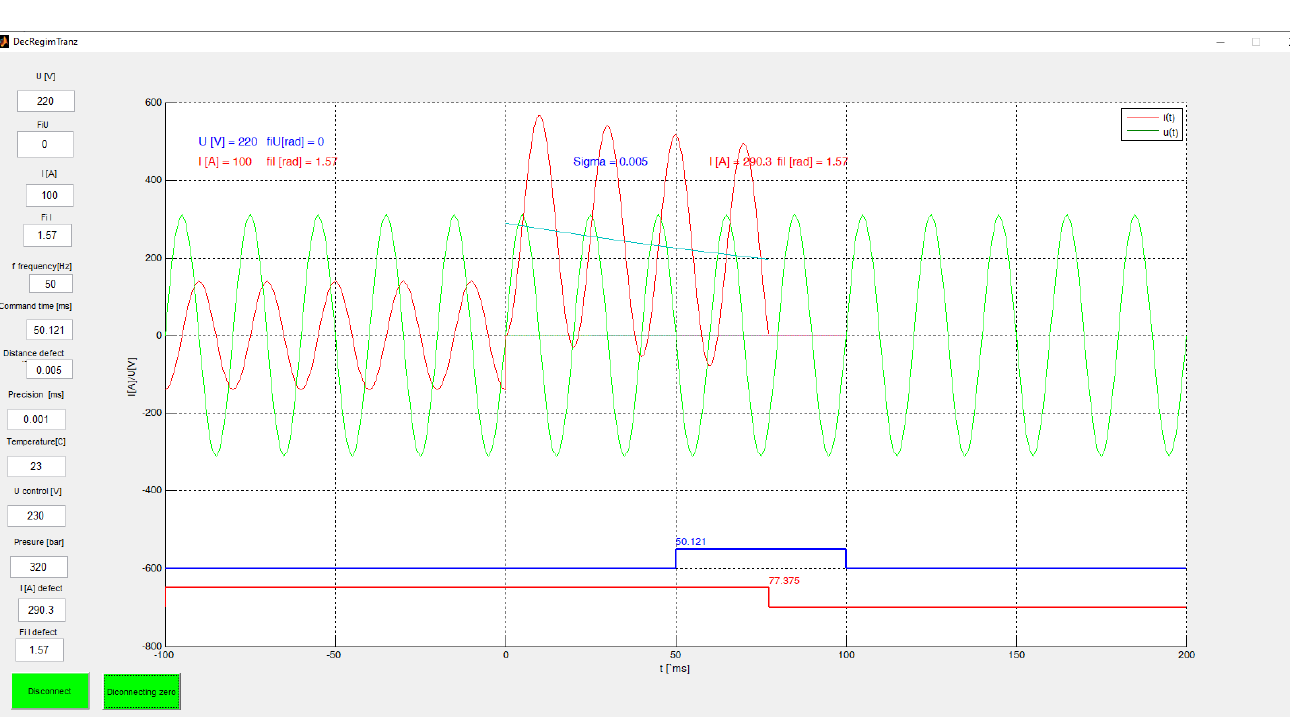
Figure 16. Transient uncontrolled switching diagram for inductive load, ɸ Idef = π /2, Idef = 290.3 A, σ = 0.005, t disconnect = 31.221 ms.